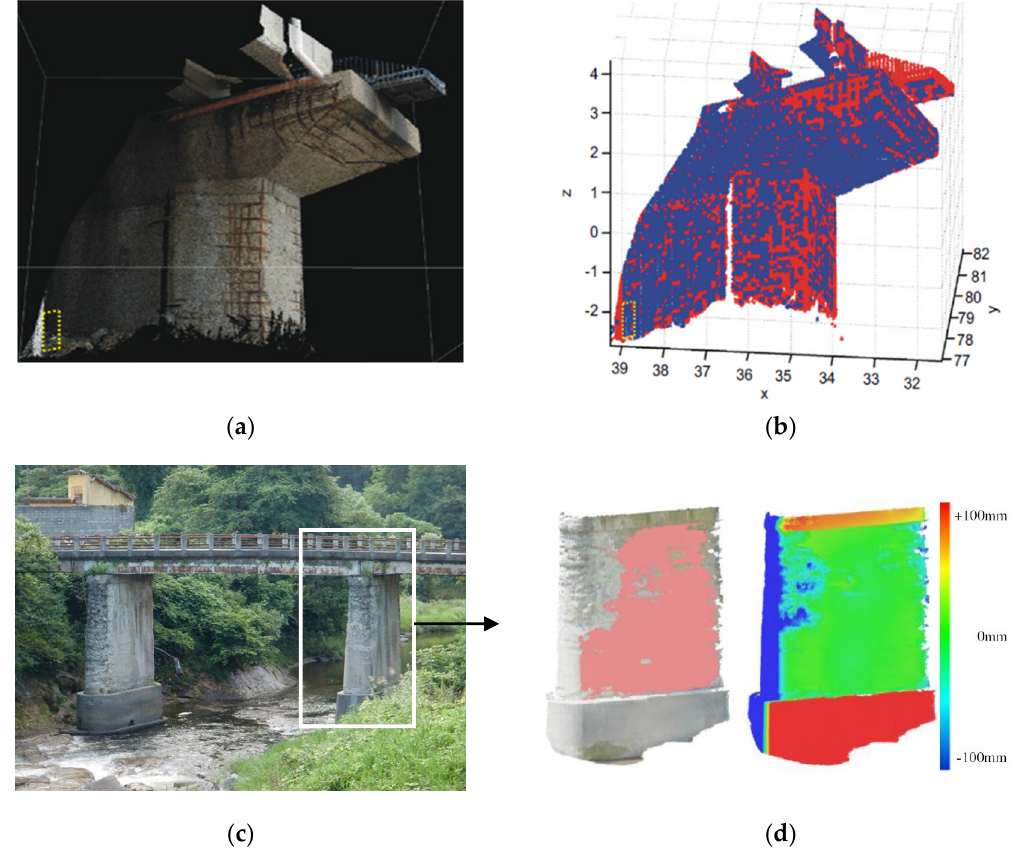
Figure 8. Surface damage detection of concrete pier: ( a ) point cloud with RGB values; ( b ) results of using curvature computation [106]; ( c ) concrete pier with scaling; ( d ) evaluated scaling depth [109]. Mass loss damage can also be generated due to spalling and scaling in concrete surfaces